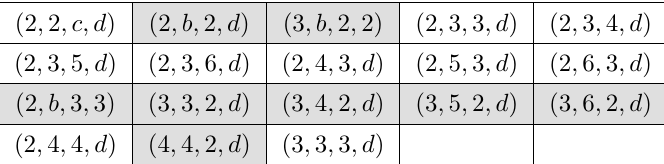
Table 6 . Infinite sequences of type III singularities. Gray entries are reducible to the previous types of singularities. This table is adapted from